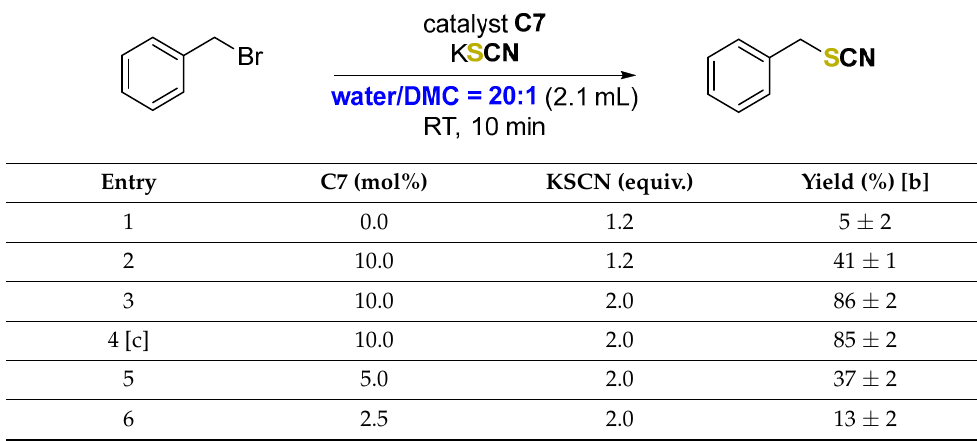
Table 2. Optimization of the reaction conditions using catalyst C7 . [a].